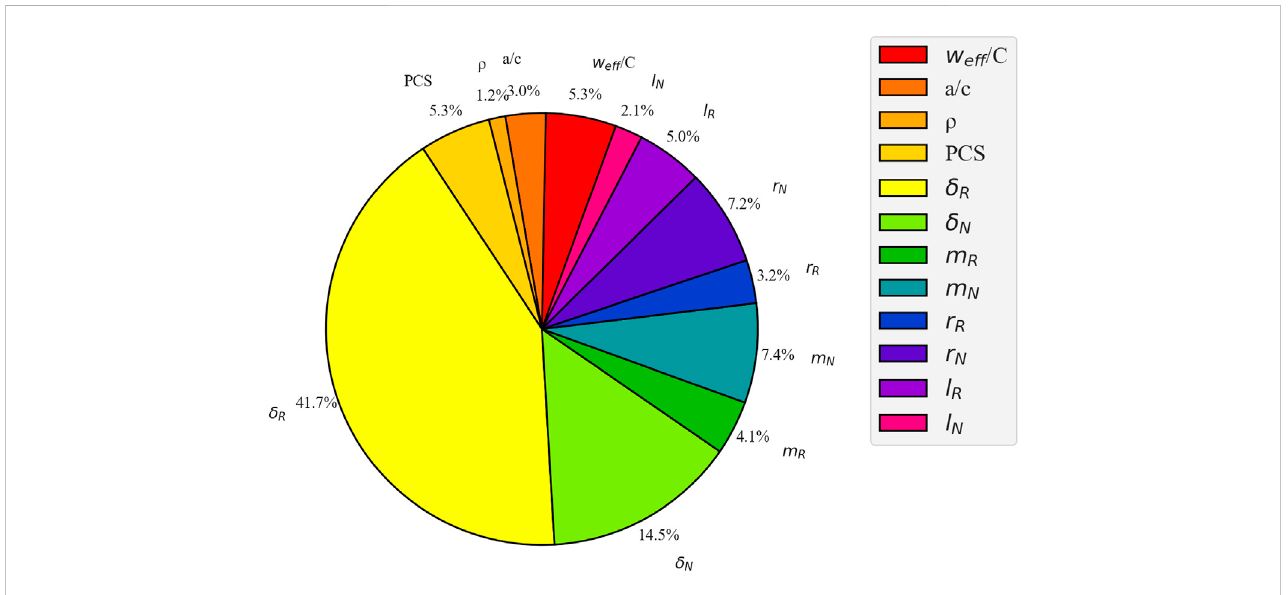
FIGURE 12 Ranking of feature importance of XGBoost